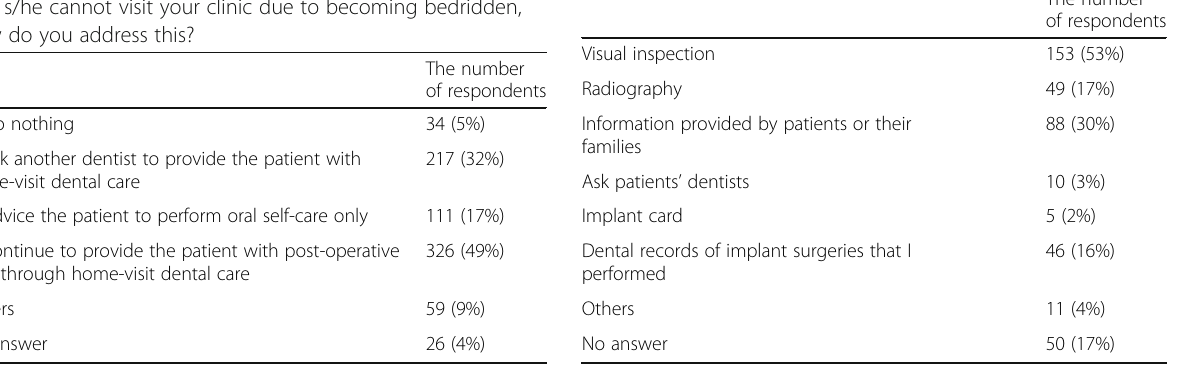
Table 4 If you are informed by one of your implant patients that s/he cannot visit your clinic due to becoming bedridden,